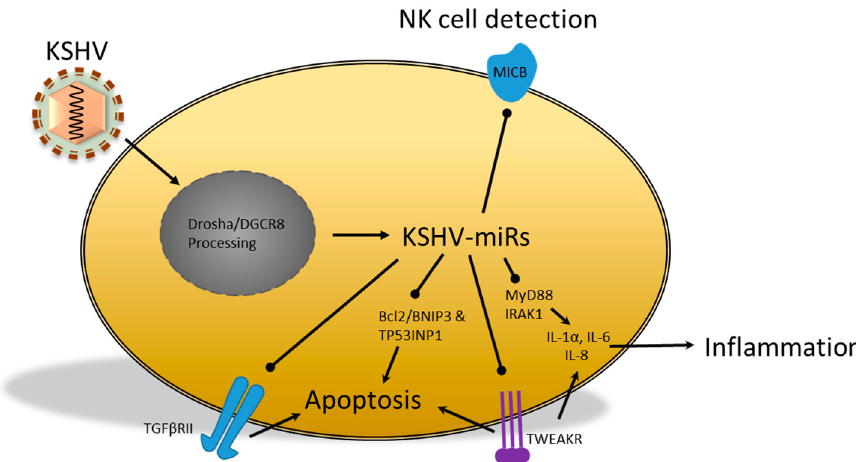
Figure 3. KSHV-encoded miRs that are able to regulate cellular targets, some of which have been shown to regulate the transcription of cytokines or their receptors, including the TGF β RII. Furthermore, KSHV miR inhibition of pro-apoptotic factors, together with reduced NK cell detection, may contribute to cell survival and increased viral persistence, cytokine production, cytokine signaling, NK cell detection and apoptosis in various cell types. The vmiR targeting of MyD88, IRAK1, TGF β RII and MICB has been demonstrated in reporter assays, while TWEAKR, Bcl-2/BNIP3 and TP53INP1 have been verified by PAR-CLIP analysis. TWEAKR, tumor-necrosis factor-related receptor; IRAK1, Interleukin-1 receptor-associated kinase 1; BNIP3, BCL2/Adenovirus E1B 19kDa Interacting Protein 3; TP53INP1, Tumour protein p53 Inducible Nuclear Protein 1; MyD88, myeloid differentiation primary response protein.